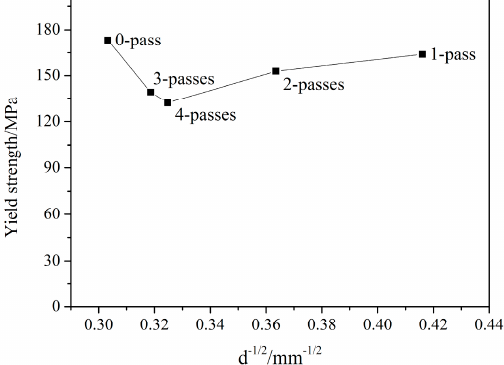
Figure 8. Yield strength versus the square root of grain size ( d − 1/2 ) for as-extruded and ECAPed Mg-1Y alloys.